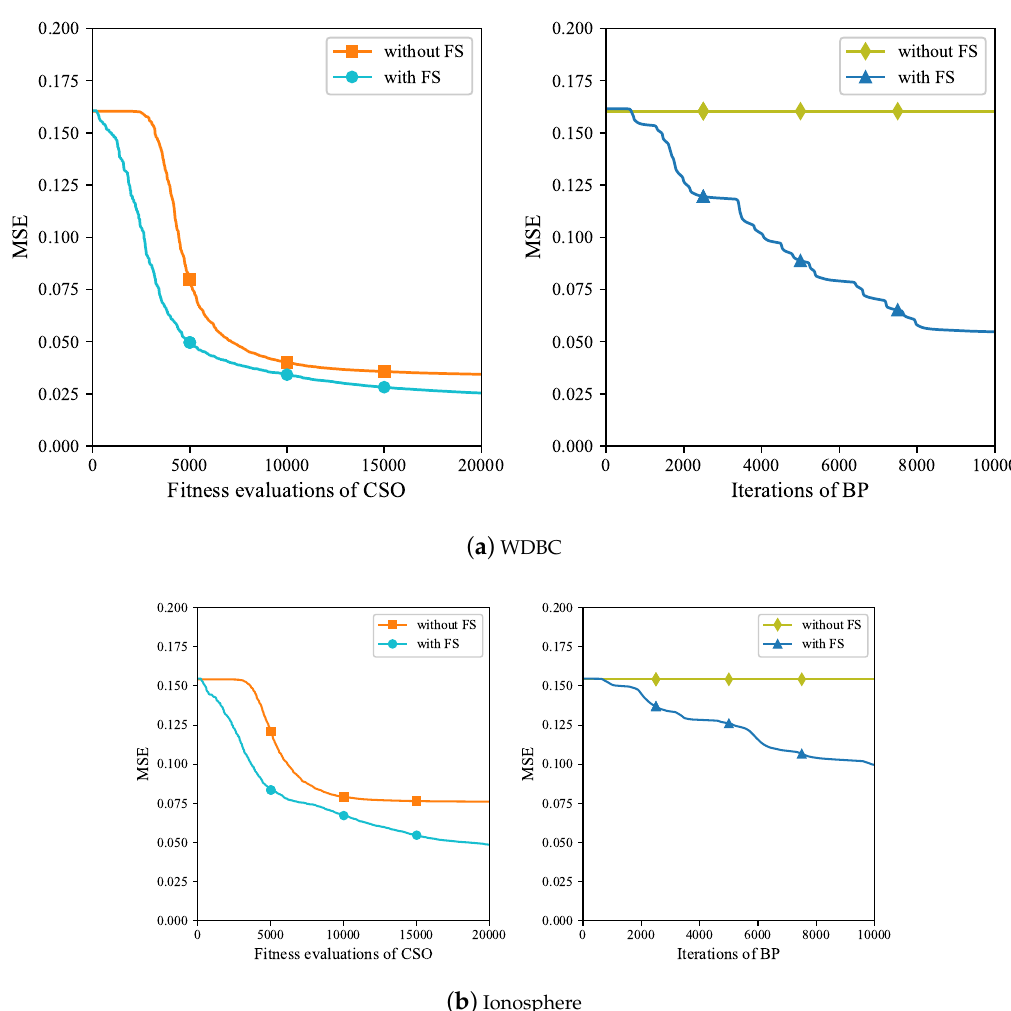
Figure 7. The average convergence curves of four training methods for two